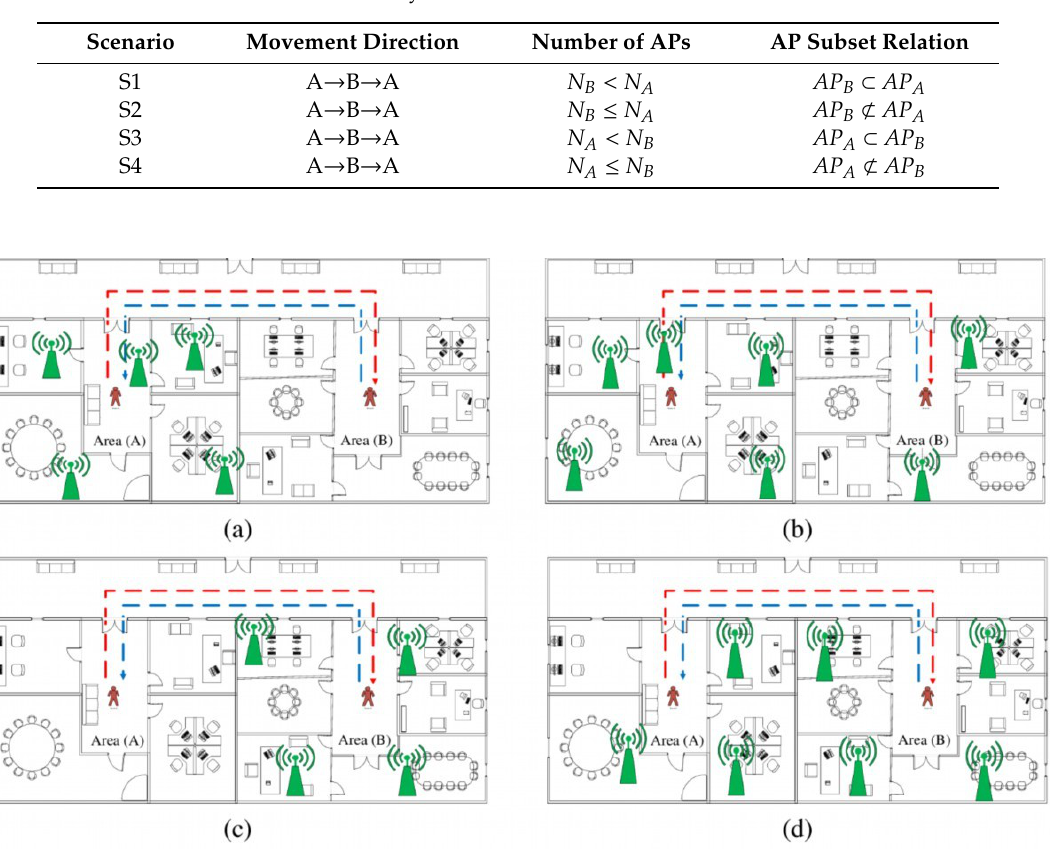
Figure 1. Evaluation scenarios of different areas in an environment according to access point